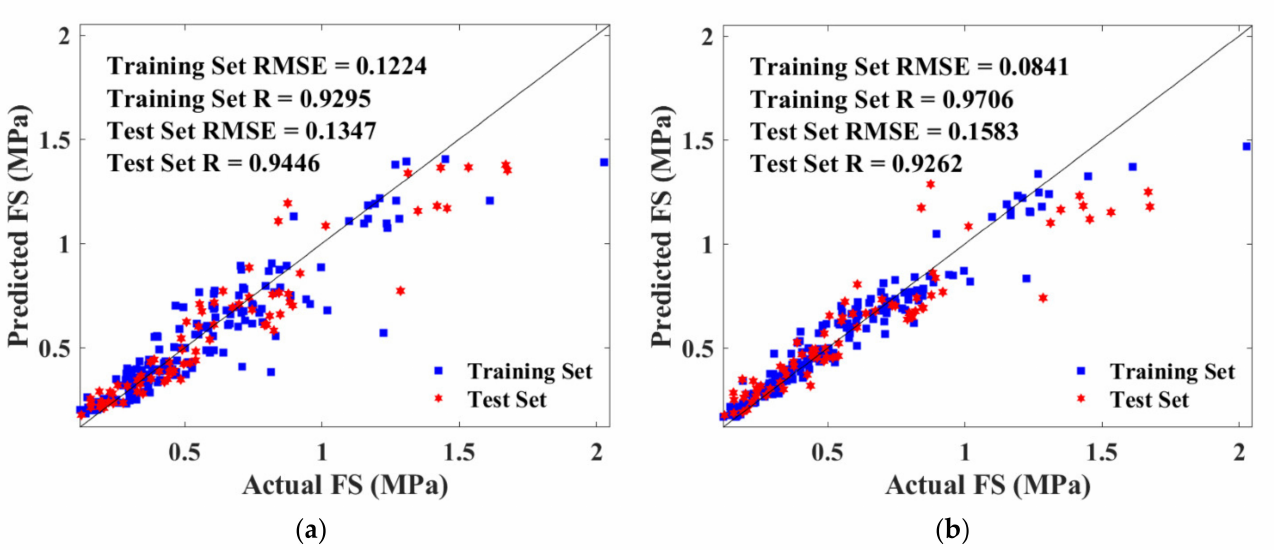
Figure 23. Scatter plot of predicted and actual FS of training and test sets: ( a ) BAS-BPNN model; ( b ) BAS-FR model.